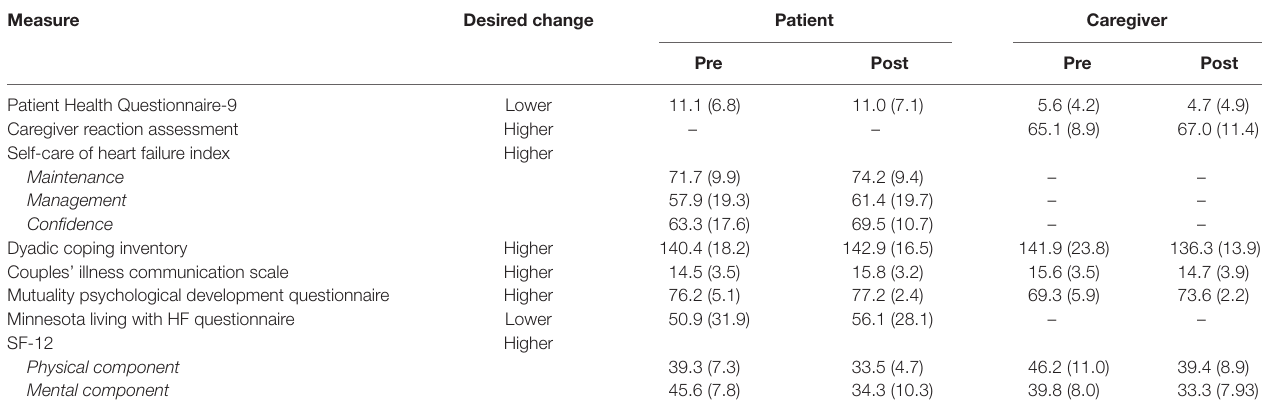
TaBle 3 | Unadjusted change scores for pilot study participants, M (sD).